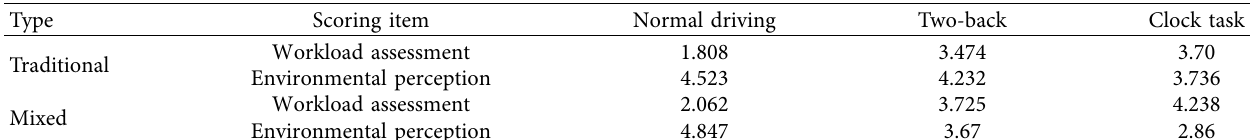
Table 4: Results.